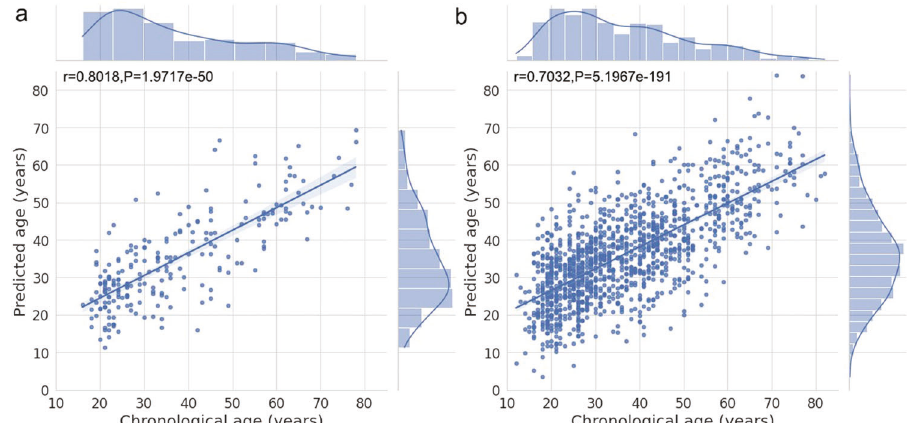
Fig. 2 Correlation between the chronological age and predicted age. a The predicted age (y-axis)on the validation set. b The predicted age on the test set. The lines represent the regression results and the shades correspond to the 95% con fi dence interval.